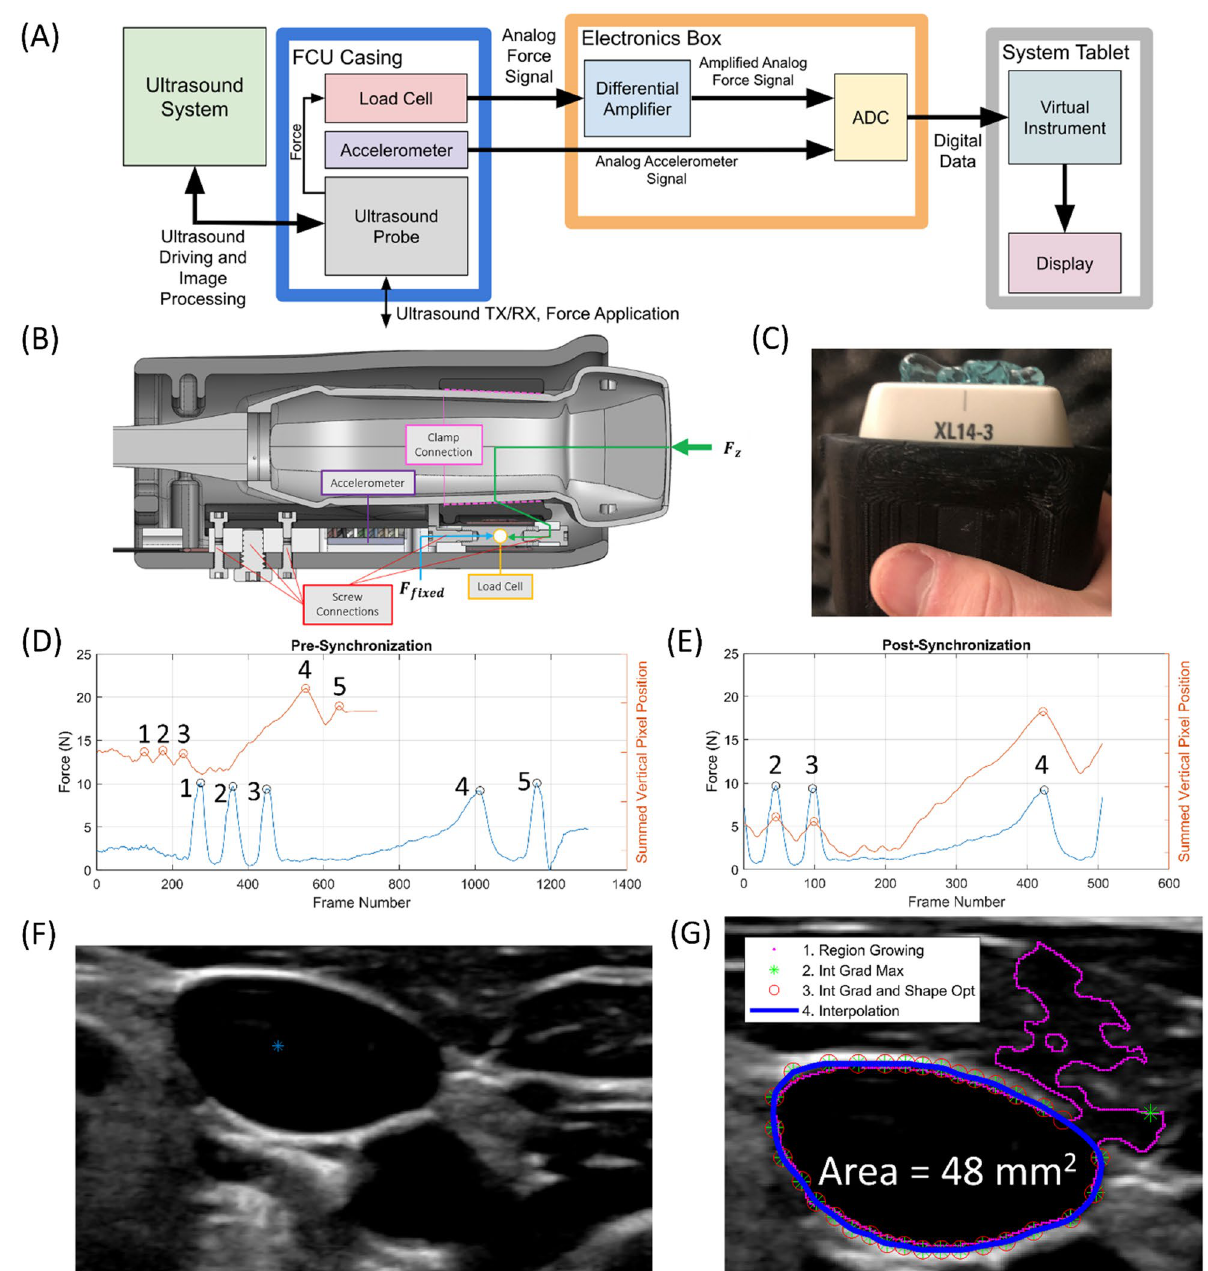
Figure 1. ( A ) Force-coupled ultrasound data collection block diagram. ( B ) CAD diagram of force-coupled ultrasound probe longitudinal cross-section. The force transmission is shown in green from the imaging surface of the ultrasound probe to the clamp connection to the load cell. ( C ) Picture of handheld probe with ultrasound gel on it. ( D ) Force and optical flow overlay pre-synchronization. Force is in blue while optical flow is in orange. Synchronization-relevant peaks are marked. ( E ) Force and optical flow overlay post-synchronization. Force is in blue while optical flow is in orange. Synchronization-relevant peaks are marked. ( F ) IJV detection with seed point indicated by blue asterisk in subject 2. ( G ) Segmentation of an open IJV with all intermediate steps included in subject 2. The pink indicates the first stage region growing output. The green asterisks represent the second stage radial line intensity gradient maximization output. The red circles represent the third stage intensity gradient and shape optimization. The blue tracing represents the final 2000-point interpolation